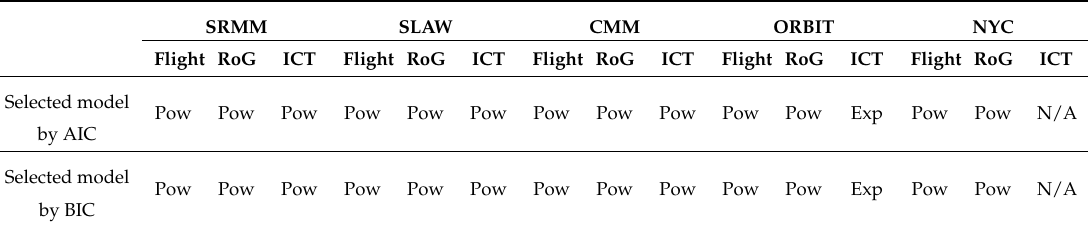
Table 4. Results from AIC and BIC between a truncated power-law distribution (denoted as Pow) and an exponential distribution (denoted as Exp) over flights, the radius of gyration (denoted RoG), and ICTs of the New York City trace (denoted NYC) and various synthetic models with the synthetic map. SRMM SLAW